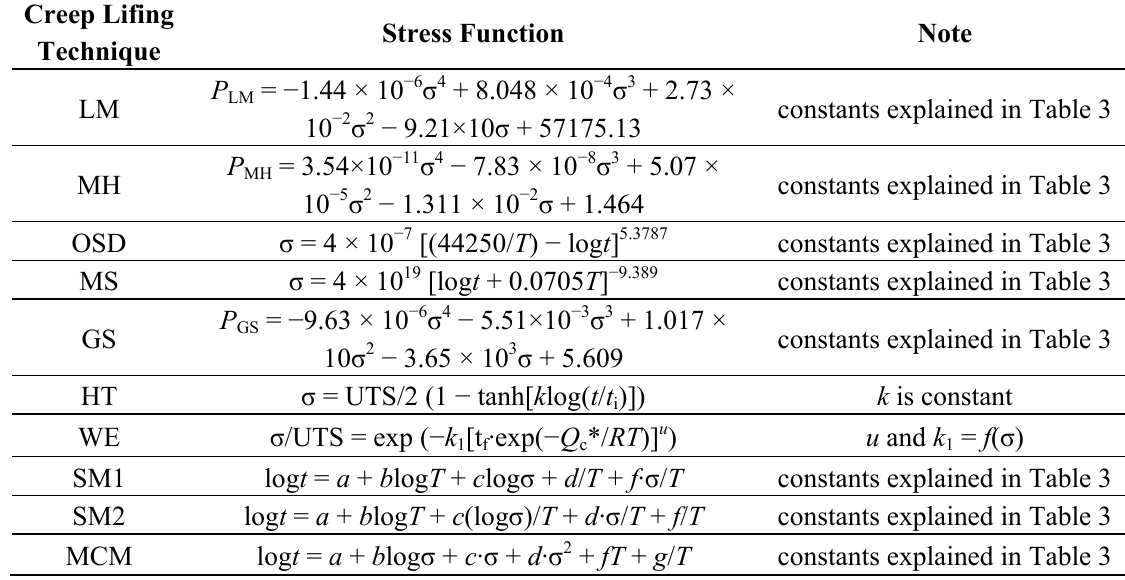
Table 2. Equations and parameters of creep life approaches.